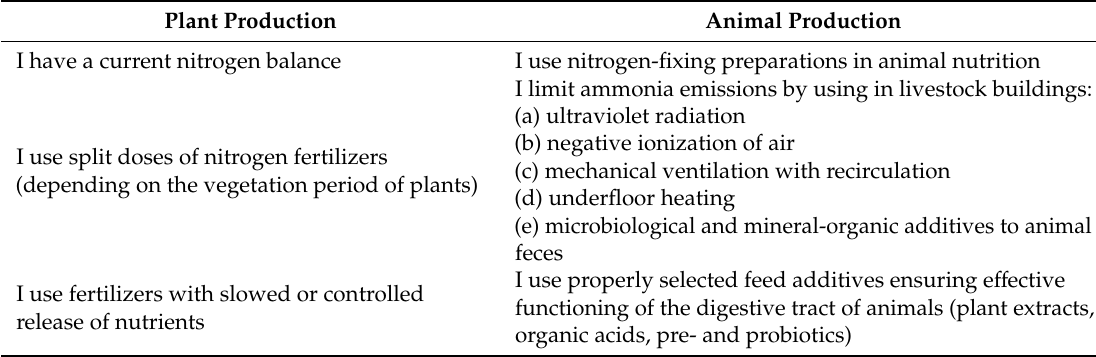
Table 3. Questions in the survey regarding low-carbon farming practices in the area of